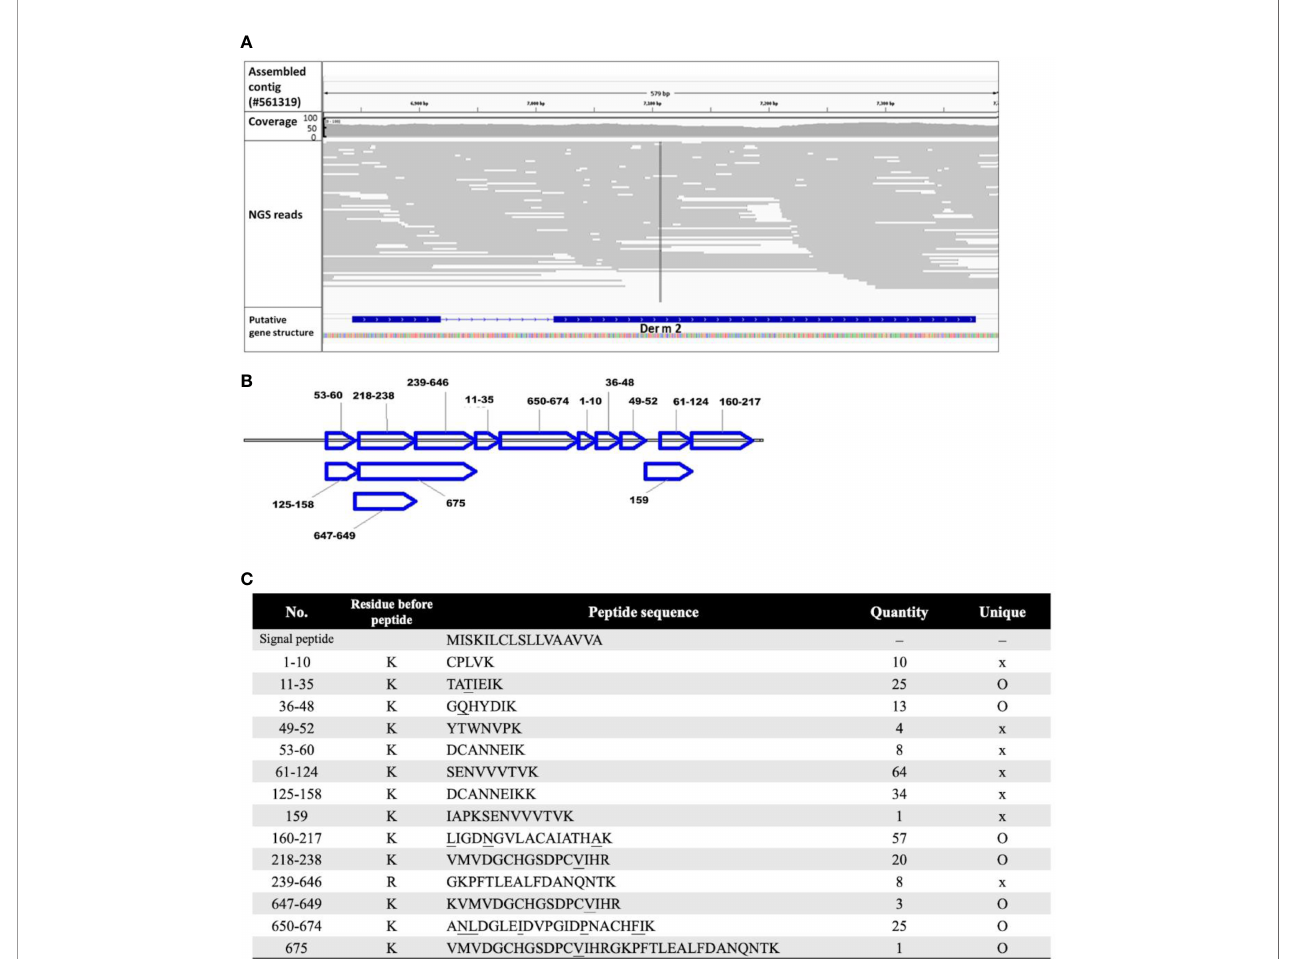
FIGURE 1 | The annotated sequence of allergic Der m 2 component. (A) The predicted DNA sequence of putative Der m 2 was shown by Interactive Genomics Viewer (IGV) with the aligned NGS reads as gray lines. The fi rst and second rows show the assembled contig sequence (con fi g #561319; 7,784 bp) and the NGS read coverage, respectively. The third row shows the sorted NGS reads mapped to the corresponding region mismatching the assembled Der m genomic reference indicated by color with alpha transparency proportional to quality. The fourth row shows the predicted exon – intron structure of Der m 2 using the sim4 package. The gene track of Der m 2 strain oriented by arrow and the bar and line indicated the exon and intron region, respectively. (B) The LC-MS/MS proteomic data showed the speci fi c fragment of deduced 146-amino acid sequence of Der m 2 ; the sequence covered 82.2%. The peptide fragments were mapped to the Der m 2 proteins. (C) The signal peptide and the peptides analyzed by LC-MS/MS mass spectra of Der m 2 and the quantity of each peptide from LC-MS/MS were listed, and the unique residues were